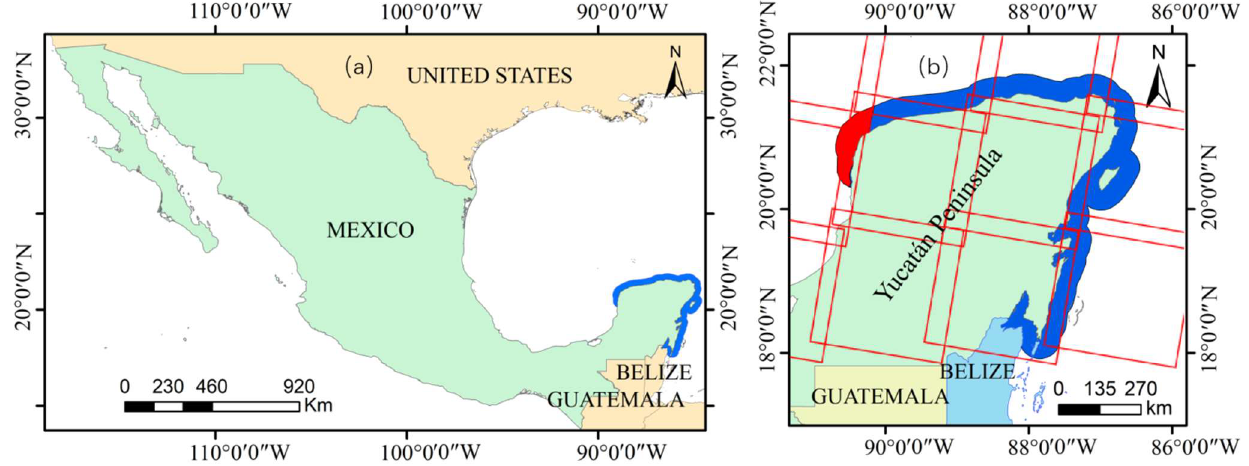
Figure 1. Location of the study area. ( a ) Location of Yucatán Peninsula in Mexico; ( b ) path and row of each Landsat image. (WRS PATH:18–21 WRS ROW:45–48).